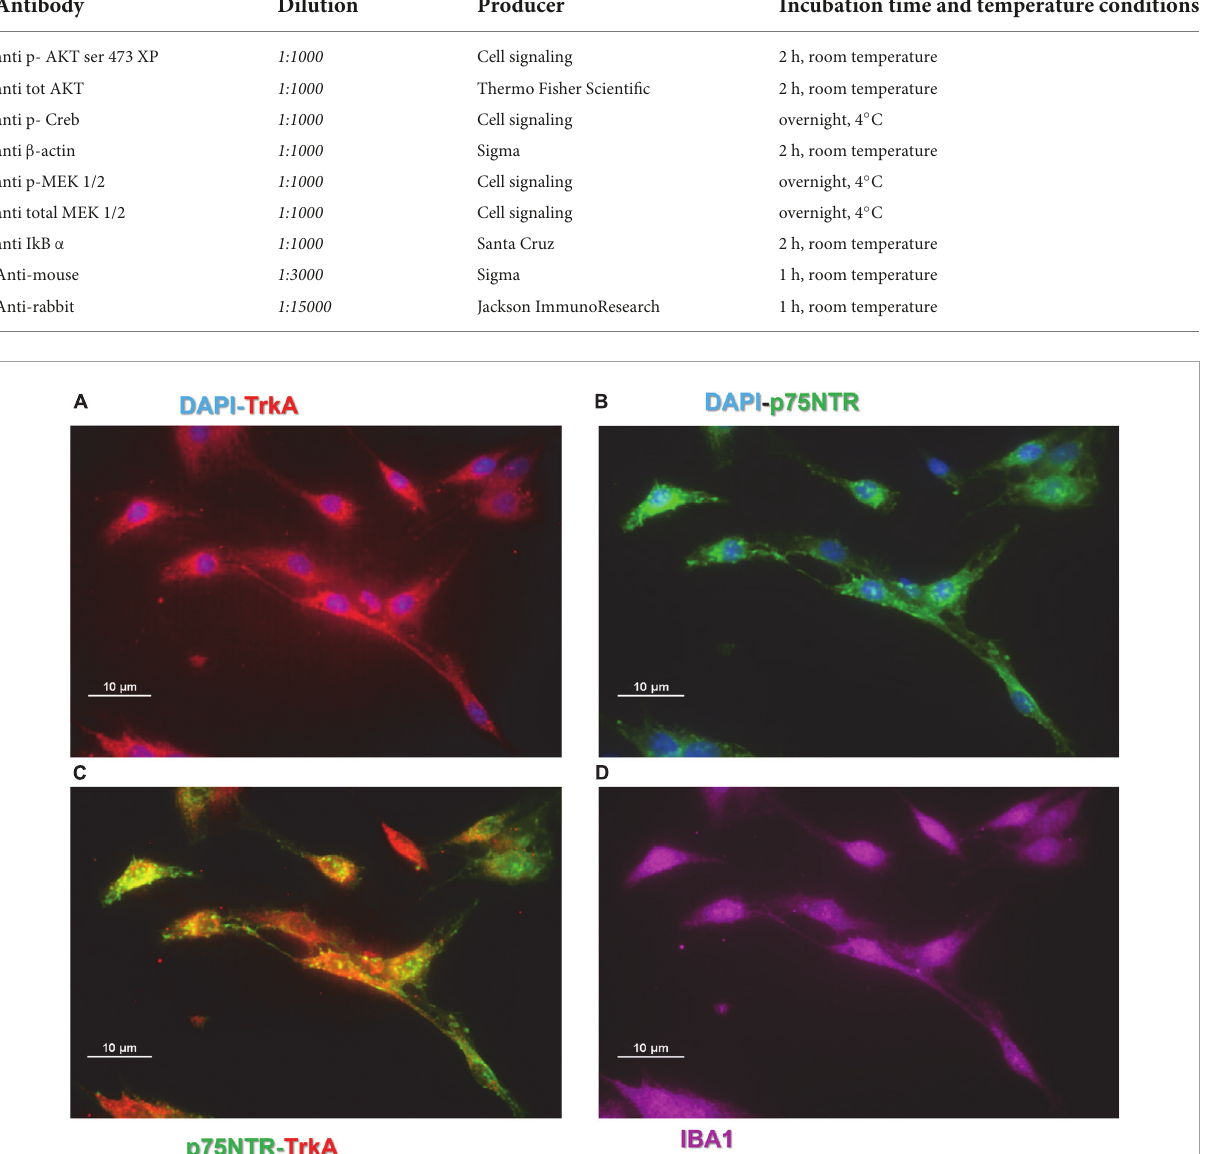
TABLE 1 Antibody information used for western immunoblotting analysis.